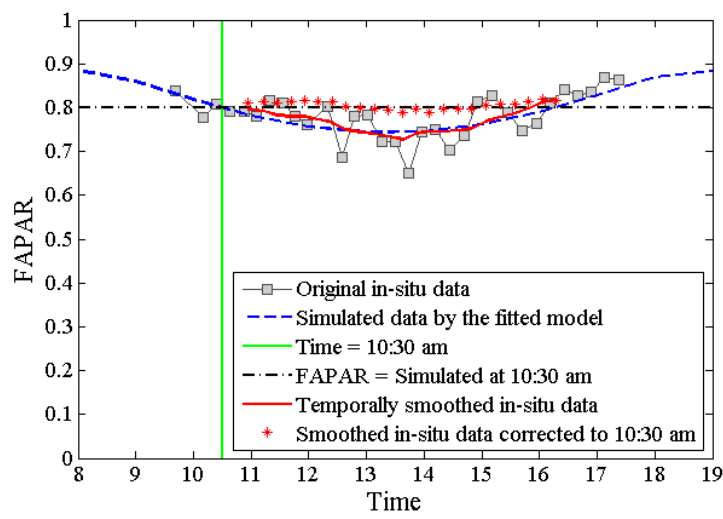
Figure 8. Validation of the temporal normalization method using in-situ FAPAR data.